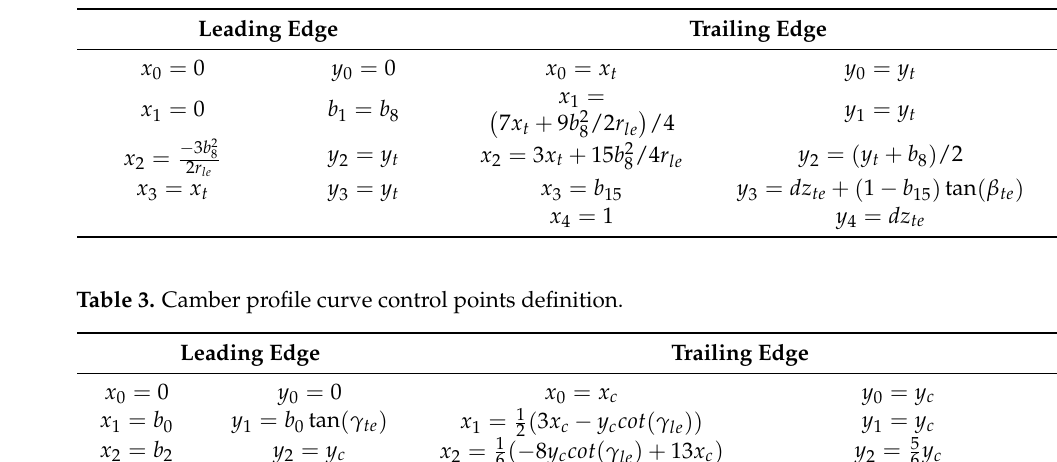
Table 2. Thickness profile curve control points definition.